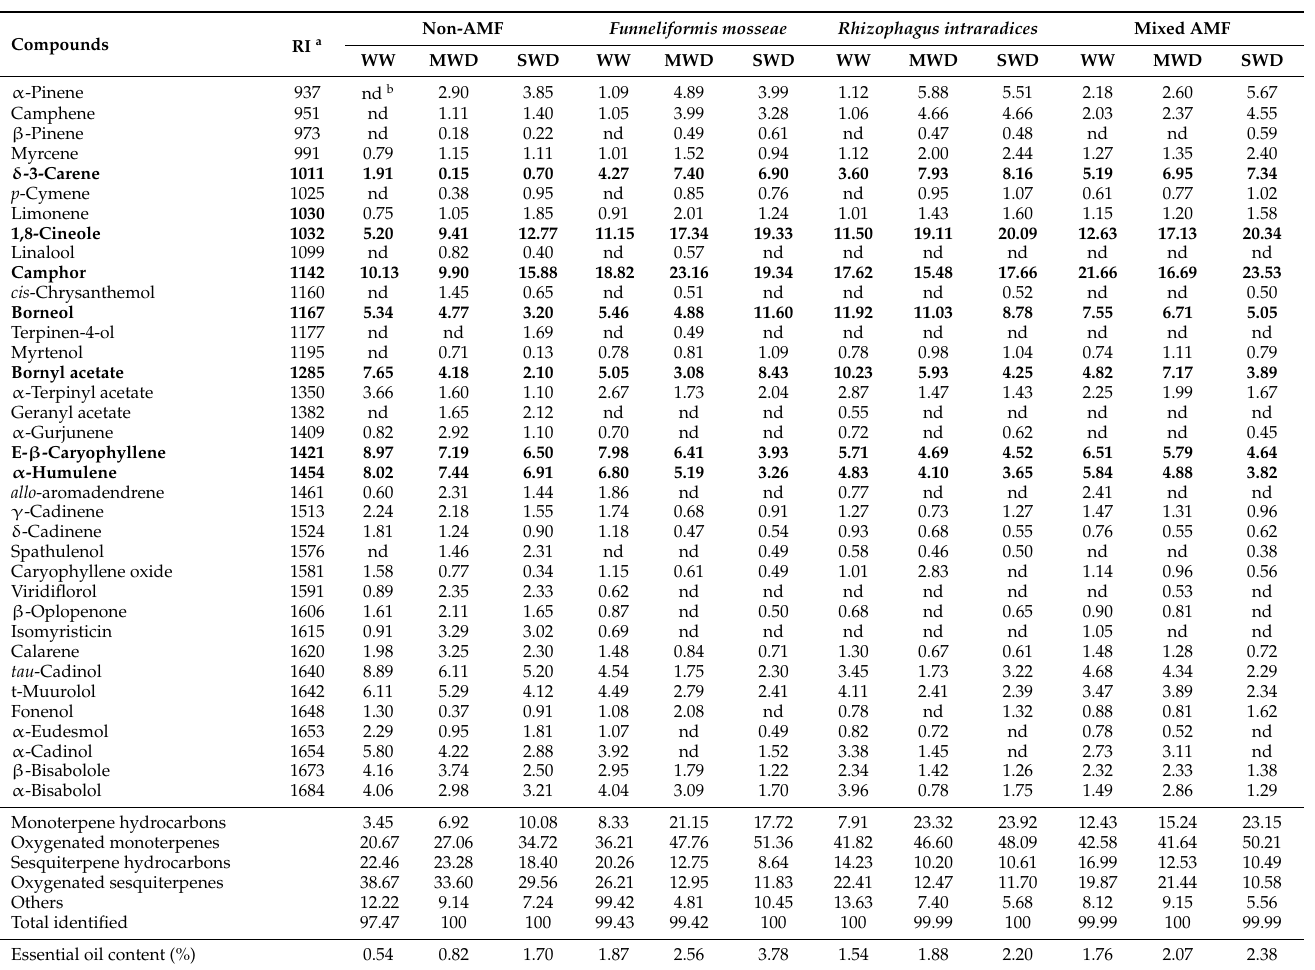
Table 4. The effects of AMF inoculation on essential oil chemical compositions and relative content (%) of S. abrotanoides under different irrigation